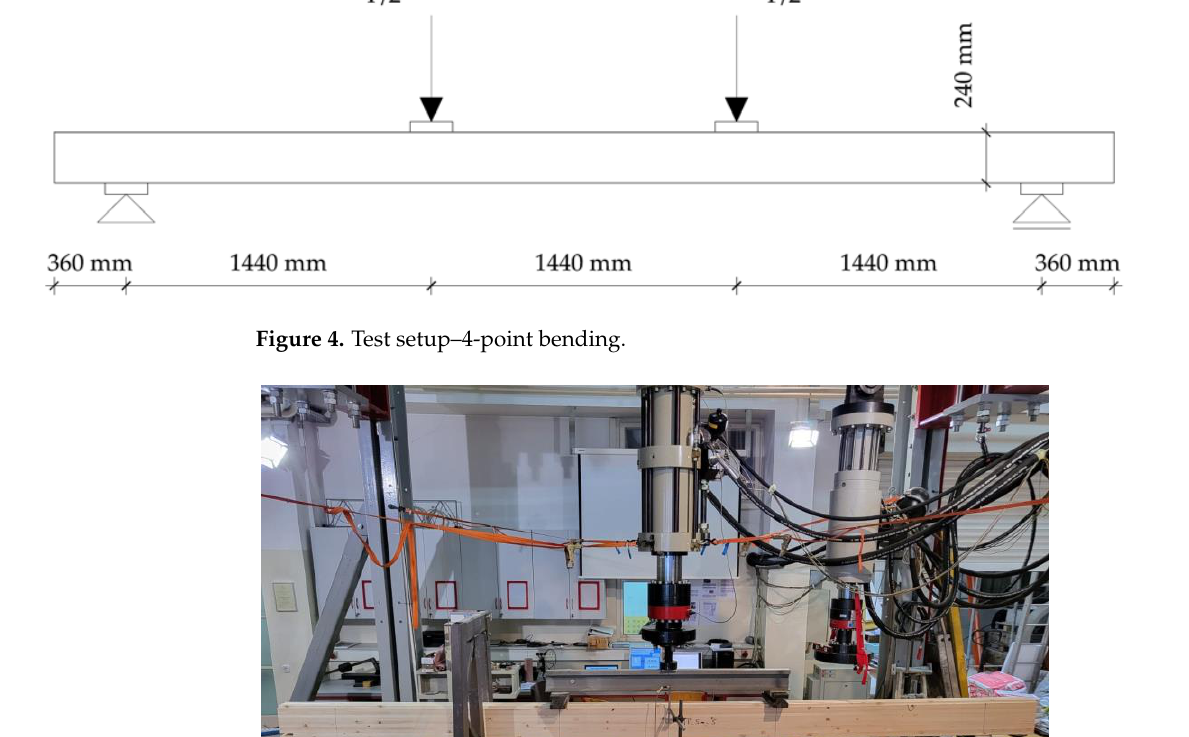
Figure 4. Test setup – 4-point bending.